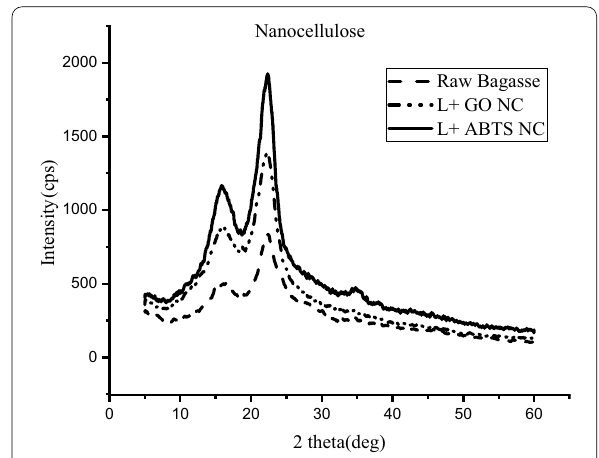
Fig. 6 X-ray diffractograms of raw sugarcane bagasse and